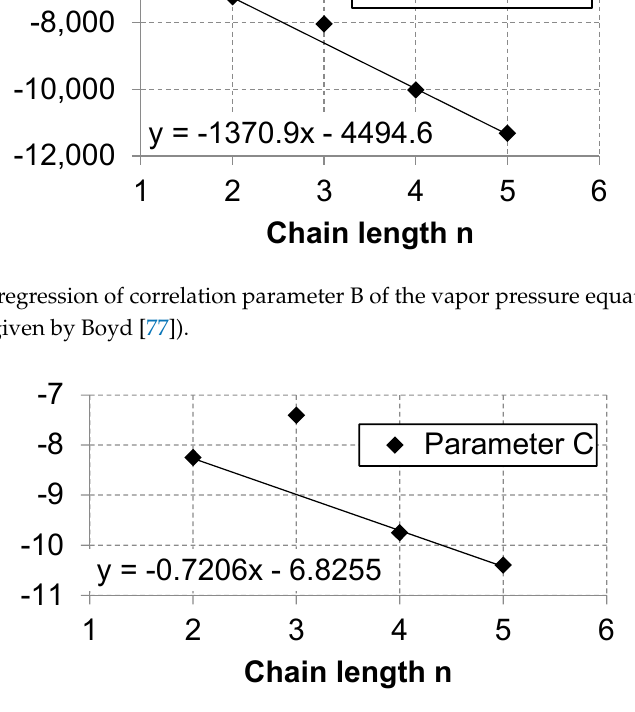
Figure A6. Linear regression of correlation parameter C of the vapor pressure equation (Equation (8)) for OME 2–5 (data given by Boyd [77]). Table A5. Normal boiling points of MG 1–10 and HF 1–10 based on the molecular structure using the group contribution method PCES (not to be used; the values used are listed in Table 7). T B / ◦